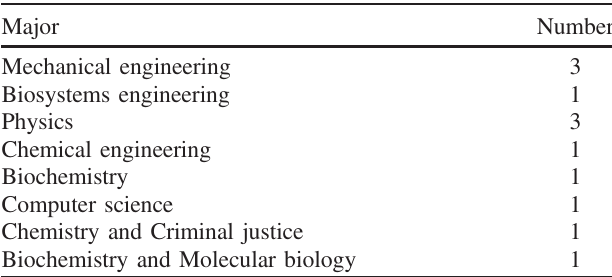
TABLE II. Majors of the learning assistants interviewed.